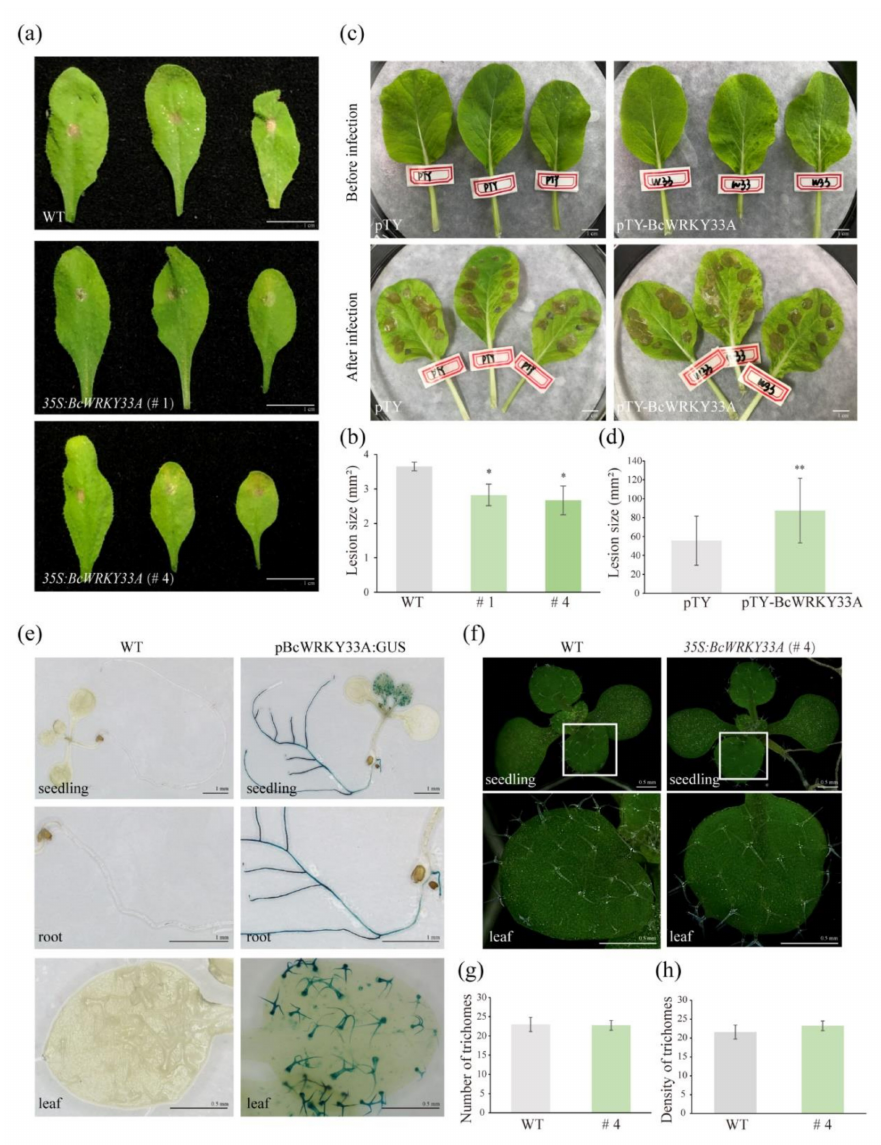
Figure 1. BcWRKY33A expressed in trichomes and mediated B. cinerea resistance. ( a , b ) The disease symptoms ( a ) and lesion size ( b ) of wild type (WT) and 35S:BcWRKY33A lines (# 1, # 4) at 2 days post inoculation dpi (dpi) with a 5- µ L droplet of Botrytis cinerea ( B. cinerea ) [30]. The average lesion size was measured based on 20 leaves from at least 6 independent plants of each line. ( c , d ) The disease symptoms and lesion size of pTY and pTY-BcWRKY33A lines at 2 dpi with many 10- µ L droplets of B. cinerea . The average lesion size was measured based on each infected area on 6 leaves from 3 independent plants of each line (note: there were at least 8 droplets of B. cinerea on each leaf). ( e ) GUS staining of twelve-day-old WT and pBcWRKY33A:GUS seedlings. ( f – h ) Trichome observation ( f ), average number of trichomes ( g ), and density of trichomes ( h ) of ten-day-old WT and 35S:BcWRKY33A (# 4) lines. After observing trichomes on rosette leaves of ten-day-old seedlings, the average number of trichomes and the density (number of trichomes per mm 2 , number/mm 2 ) of trichomes per leaf were determined, and a total of 8 independent leaves ( n = 8) were counted. Error bars represent standard deviation (SD). * p < 0.05, ** p < 0.01 (Student’s t